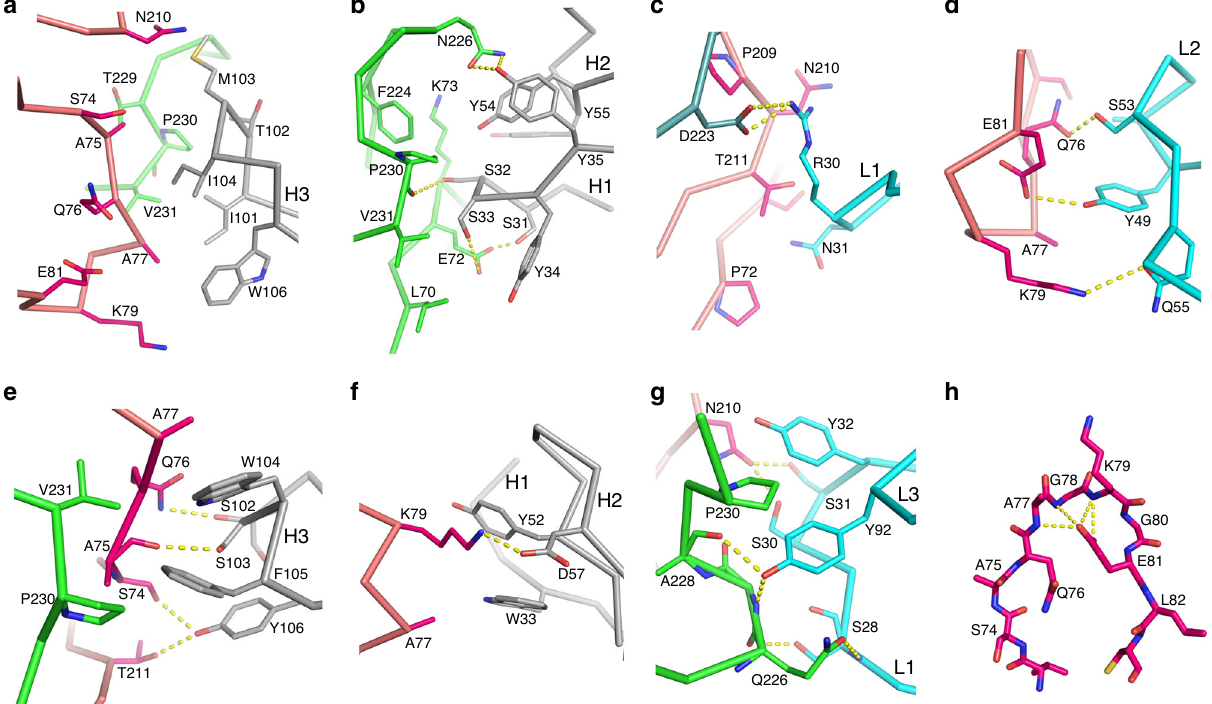
Fig. 5 Details of EV71 and Fab interactions. Interactions of EV71 with H3 ( a ), H1 and H2 ( b ), L1 ( c ) and L2 ( d ) loops in the EV71/38-1-10A complex. Interactions of EV71 with H3 ( e ), H1 ( f ) and L1 and L3 ( g ) loops in the EV71/38-3-11A complex. The main-chain backbones are drawn as thick sticks and side chains as thinner sticks with Vh in grey, Vl cyan, VP2 green and VP3 from a neighbouring protomer in salmon. Hydrogen bonds and salt bridges are shown as broken yellow sticks. h VP3 BC loop of EV71. The yellow broken sticks represent hydrogen bonds from the key stabilizing residue E81, which is also an escape mutation for both